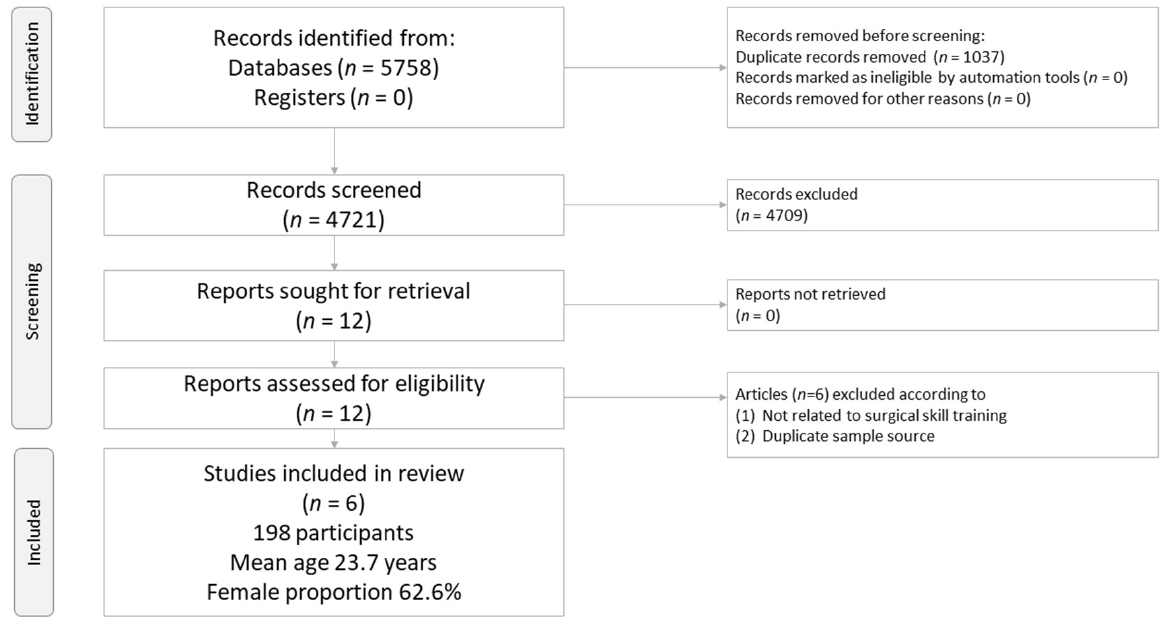
Figure 1. PRISMA2020 Flowchart of current network meta-analysis. (range 21.6–25.7) and a female proportion of 62.6% (range 46.7–72.7) were included. Table 1. Characteristics of the included randomized controlled trials.